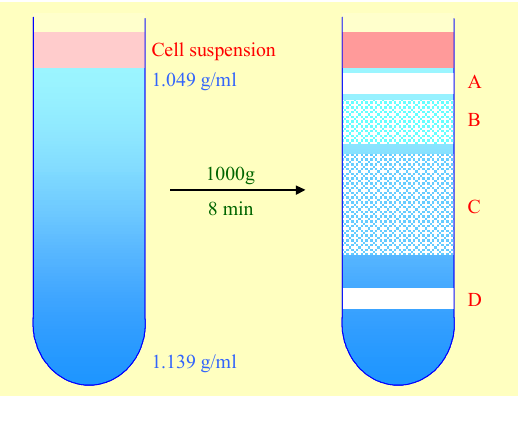
FIGURE 1 . Fractionation of gastric mucosal cells in a continuous iodixanol gradient[1]. Band A contains 80–90% parietal cells; band B is a diffuse band of less pure parietal cells; band C is a mixed cell/mucus band, and band D contains chief